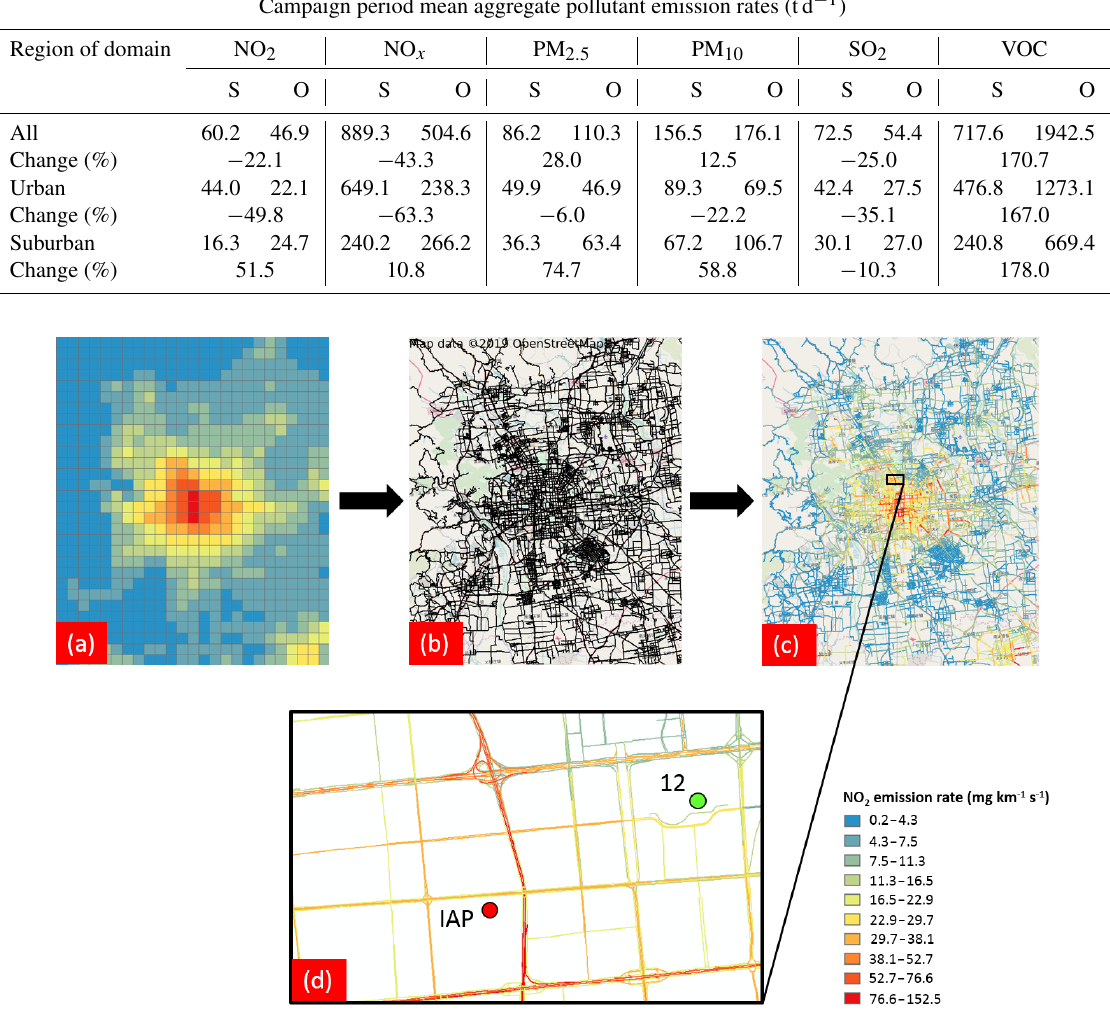
Figure 3. (a) Spatial distribution of November and December mean transportation sector MEIC Std NO 2 emissions (lowest vertical layer)